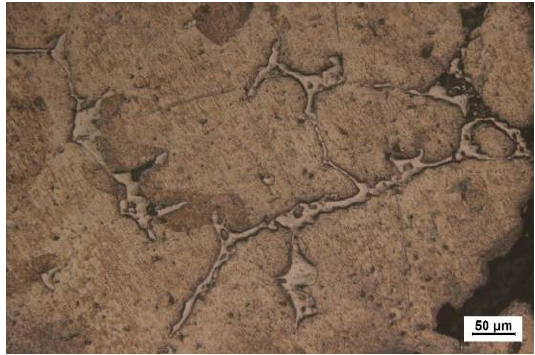
Figure 5. Enlarged image of the area in the box in Figure 4d.